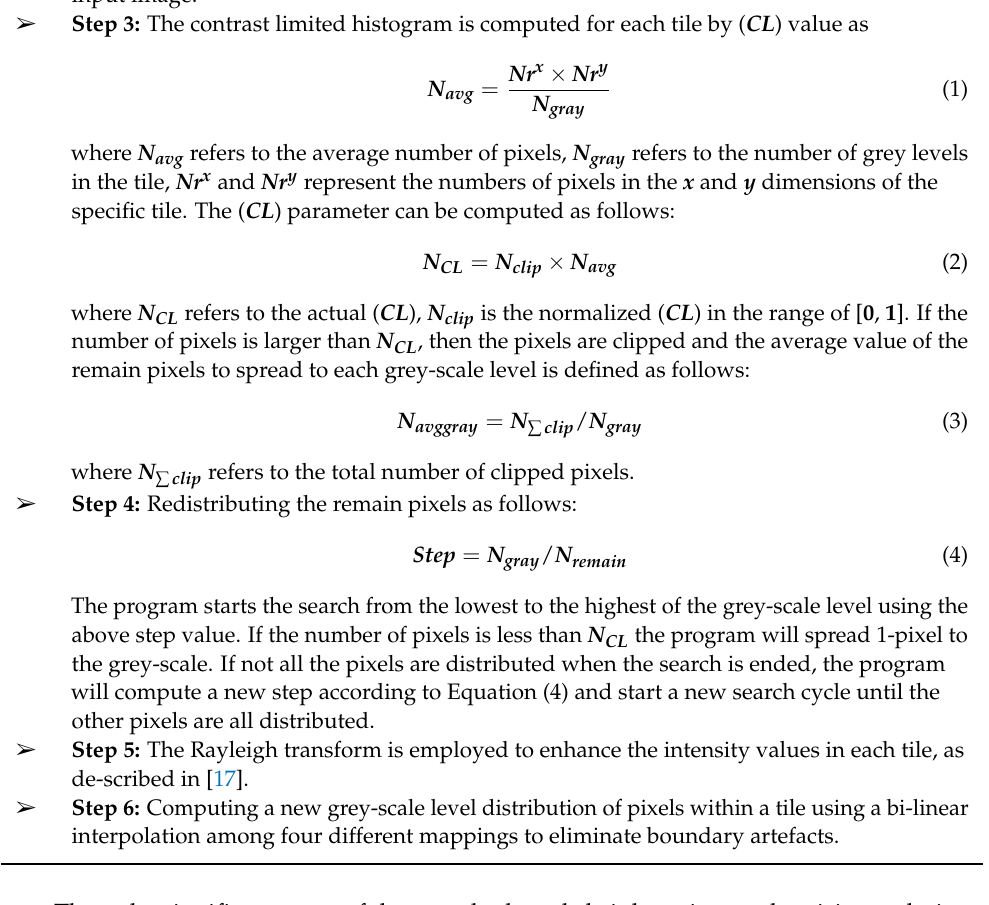
Algorithm 1: The pseudo-code of the CLAHE